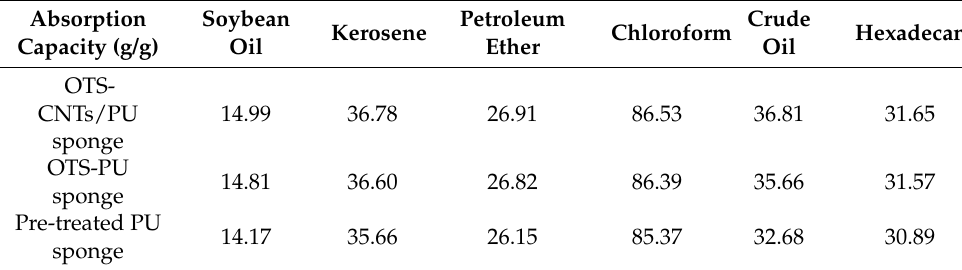
Table 2. Absorption capacity of t different PU sponges for various organic oils and solvents (20 ◦ C).